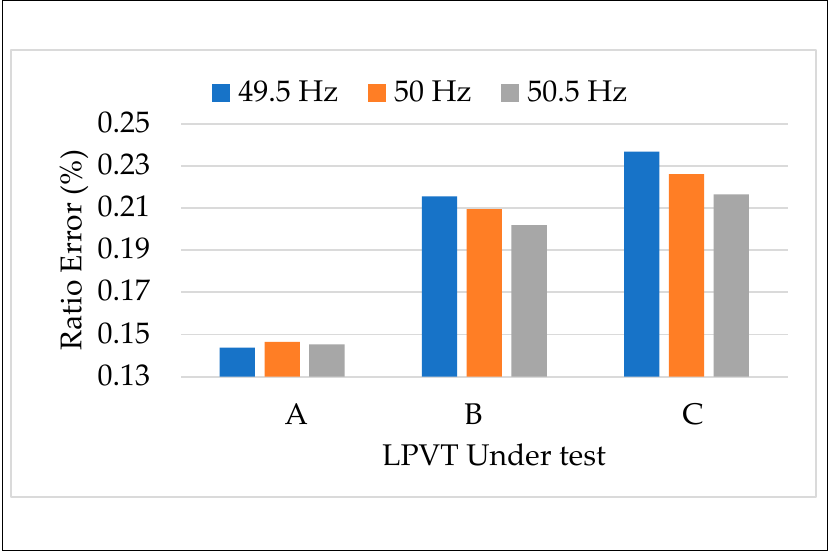
Figure 5. Ratio error vs. frequency for the three LPVTs under test.